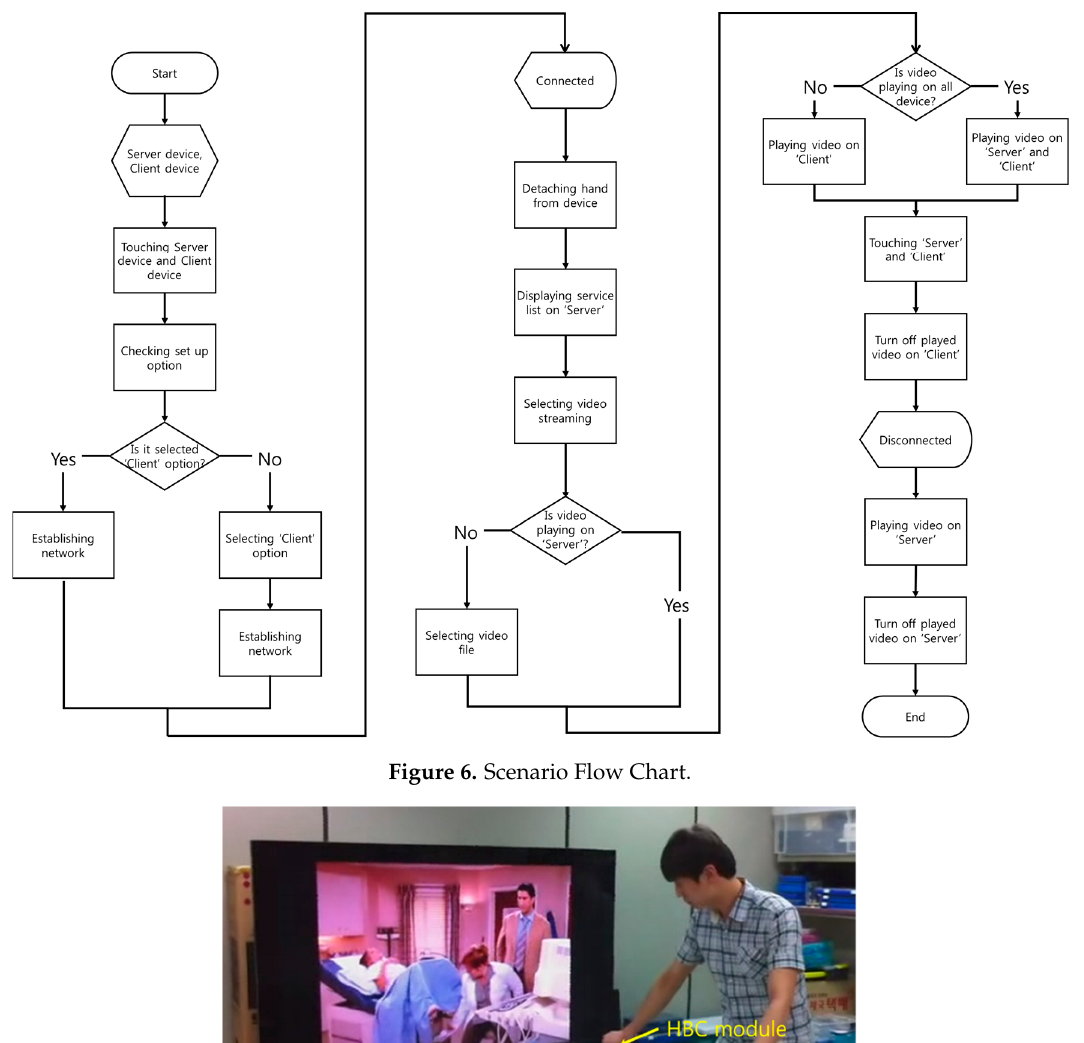
Figure 7. Touch-Based Dual-Band Communication Service demonstration.